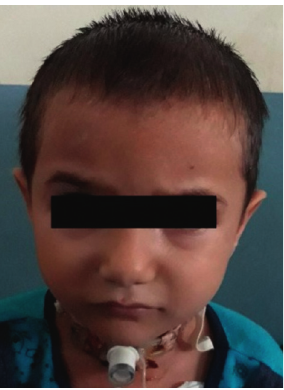
Figure 5: On the 2 nd postoperative